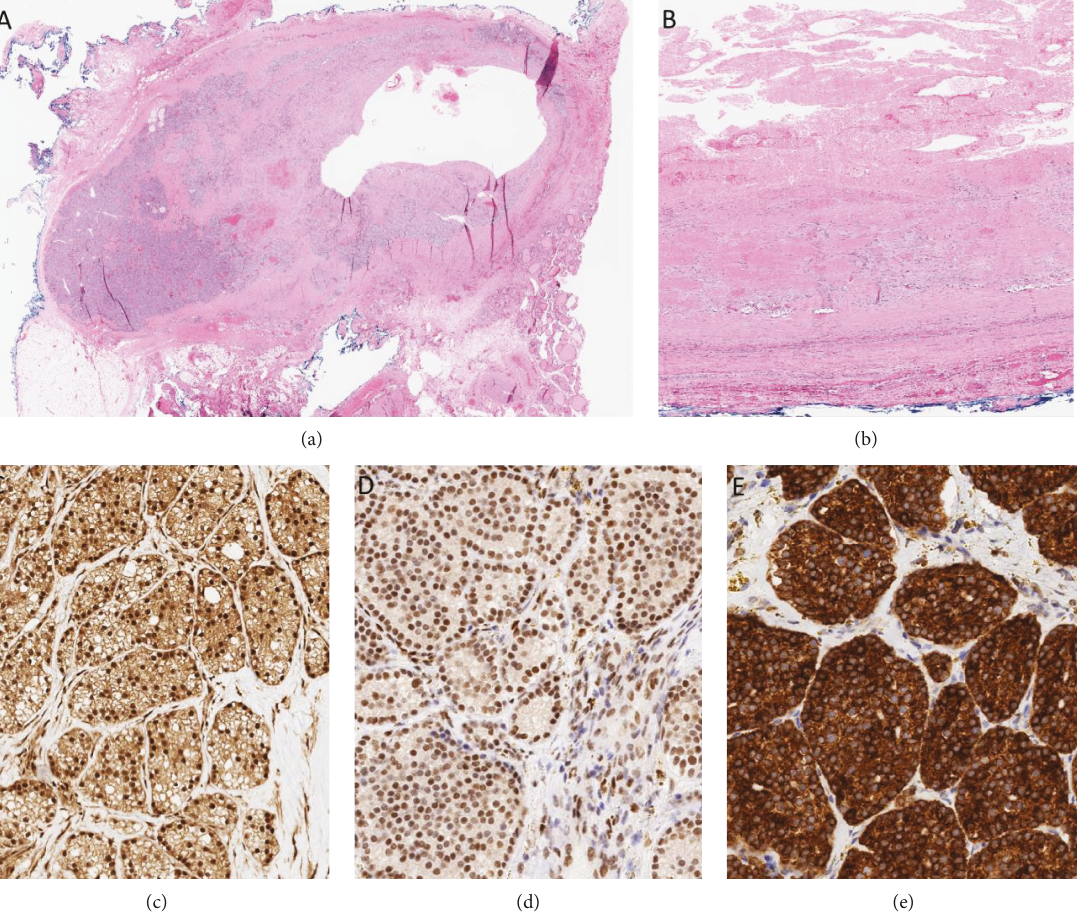
Figure 4: The specimen showed a largely infarcted enlarged cellular parathyroid gland with cystic change (a, b; hematoxylin and eosin). There was no evidence of invasive growth. There was no loss of expression for para fi bromin (c), RB (d), p27 (not shown), and bcl-2 (e). The overall clinicopathological fi ndings were consistent with an infarcted parathyroid